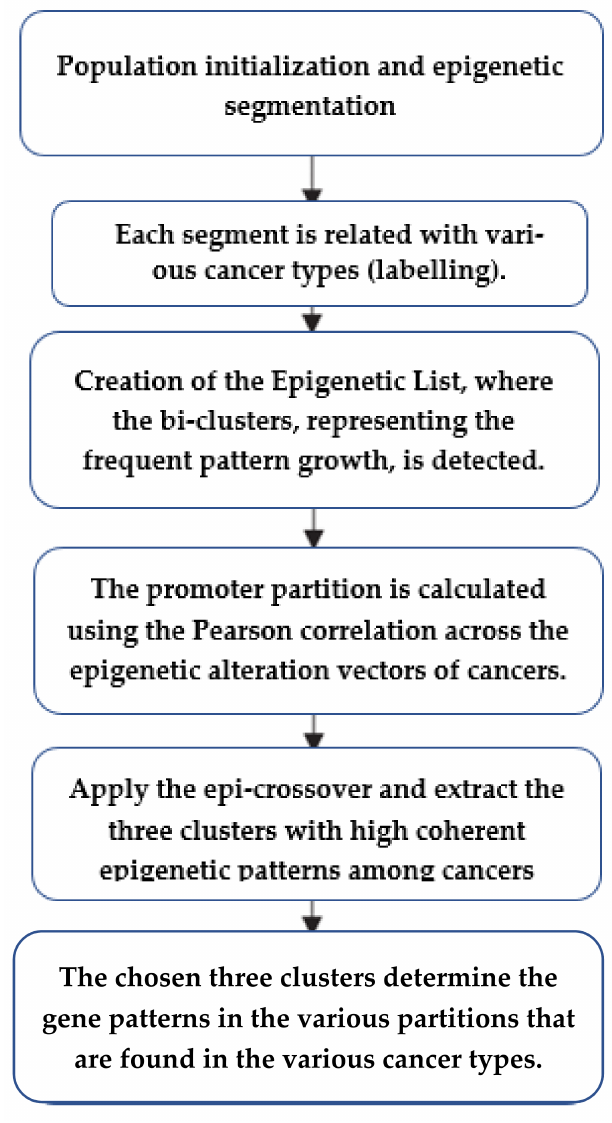
Figure 1. The flowchart of the proposed three-way clustering technique (3WC) includes preprocessing of the epigenetic marks of various cancer types and detecting the three clusters with coherent epigenetic marks among various cancer